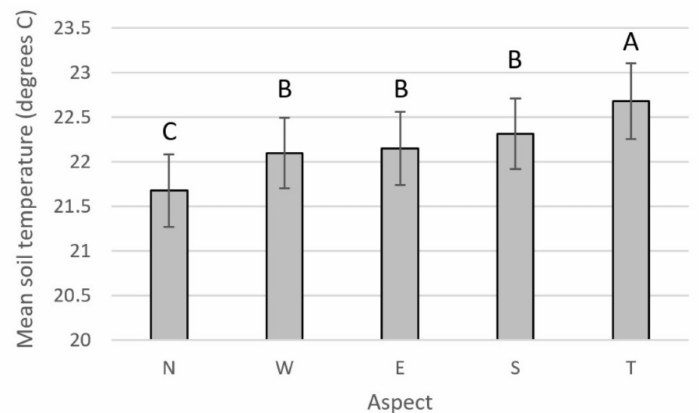
Figure 6. Mean soil temperature, across all measurement dates, on each aspect and the tops (T) of mounds. Bars indicate standard error. Di ff erent letters indicate a significant di ff erence between treatments at p < 0.05, with date and time of day included in the model.